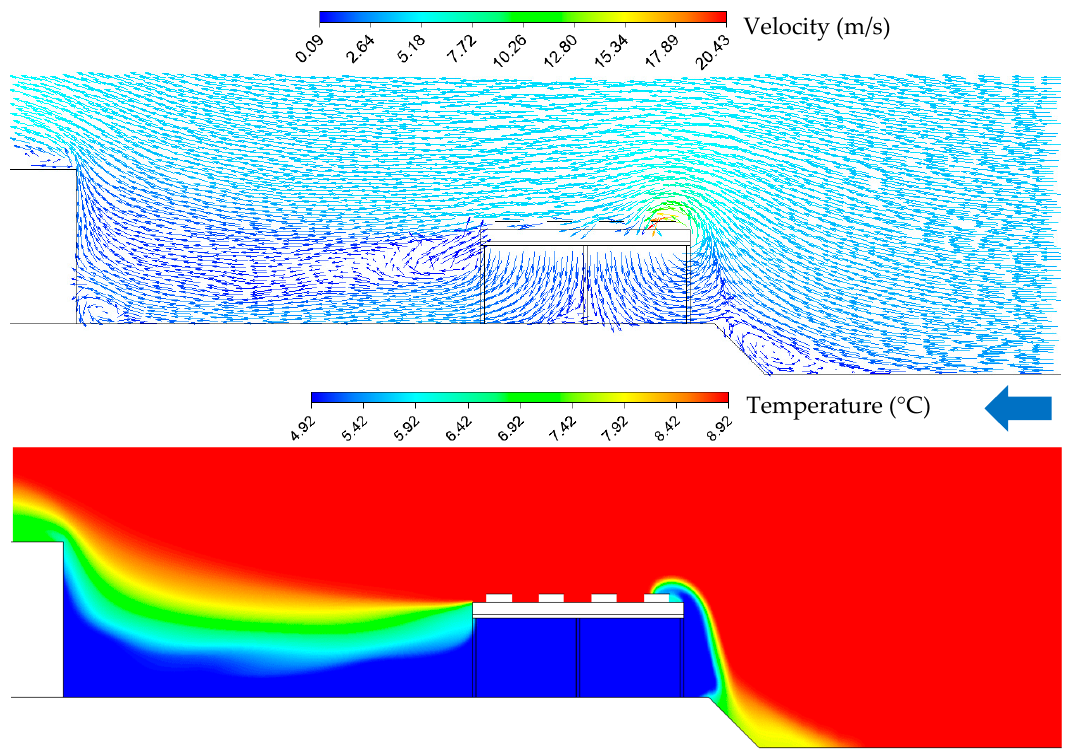
Figure 19. Temperature contour of the evaporators (top side), no building (up), real field (down) and west wind condition.